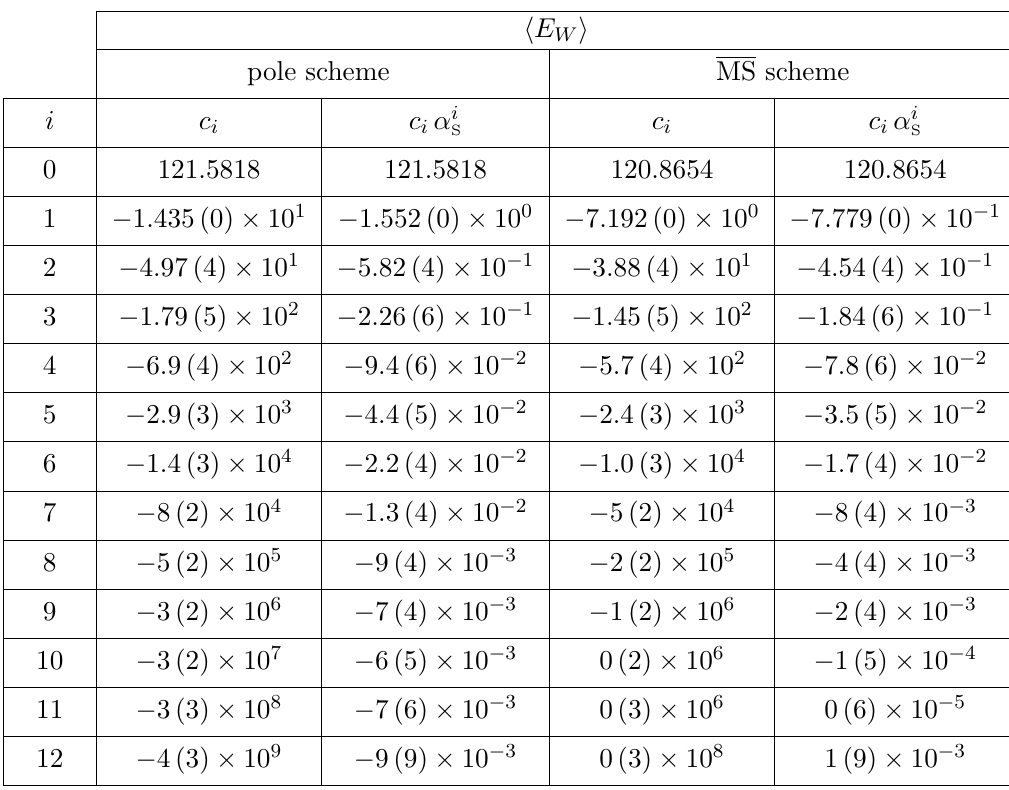
Table 6 . Coe(cid:14)cients of the perturbative expansion (8.6) of the average W -boson energy in the pole and MS-mass schemes. The errors reported in parenthesis are due to the uncertainty on the linear coe(cid:14)cient of the (cid:12)t (i.e. p 1 in eq.